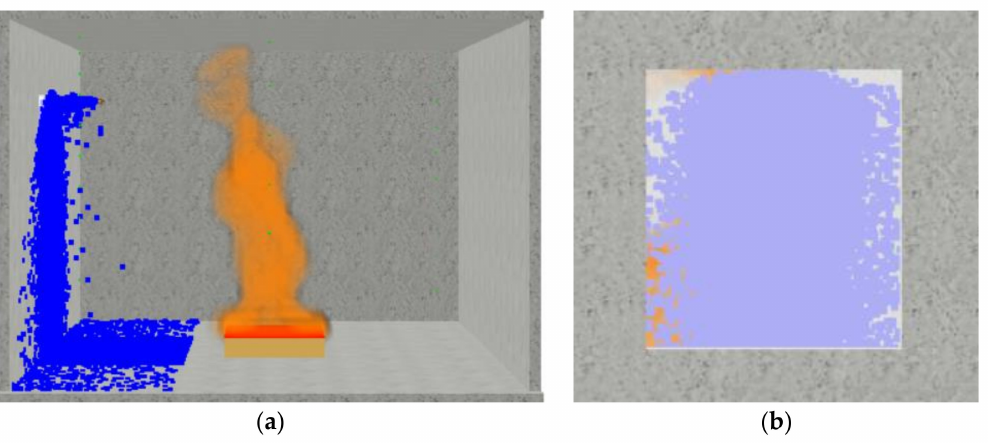
Figure 8. Window sprinkler protection experiment with a working pressure of 0.1 MPa: ( a ) sprinkler form, ( b ) window glass protective